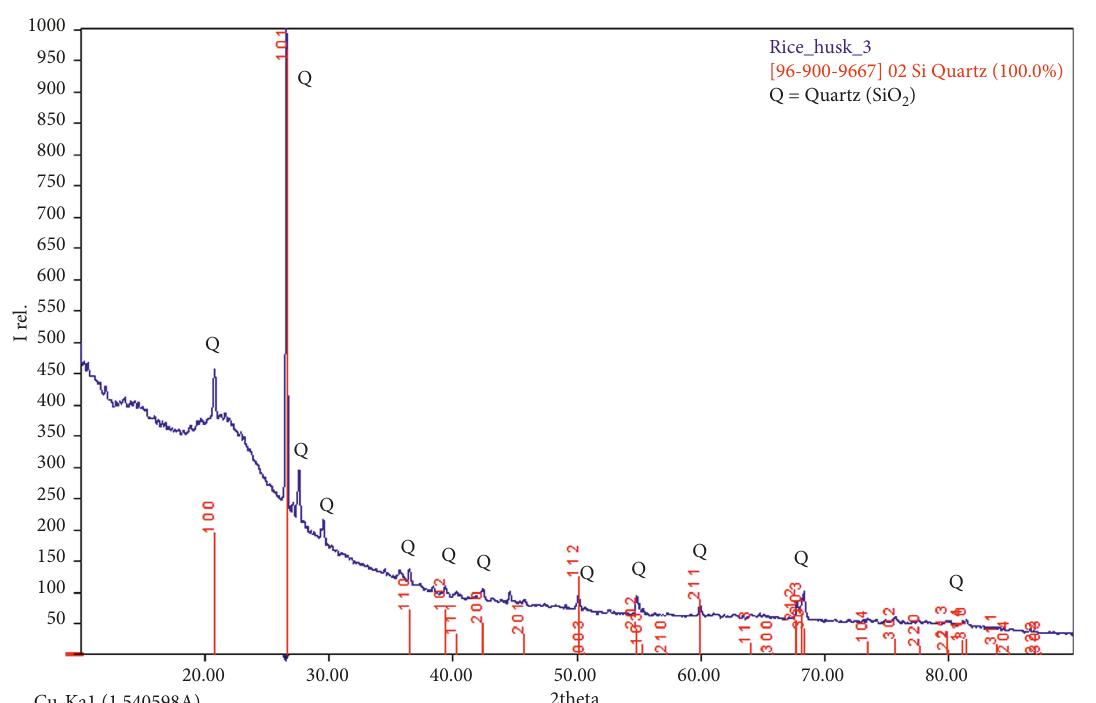
Figure 2: X-ray diffraction pattern of RHA sample.